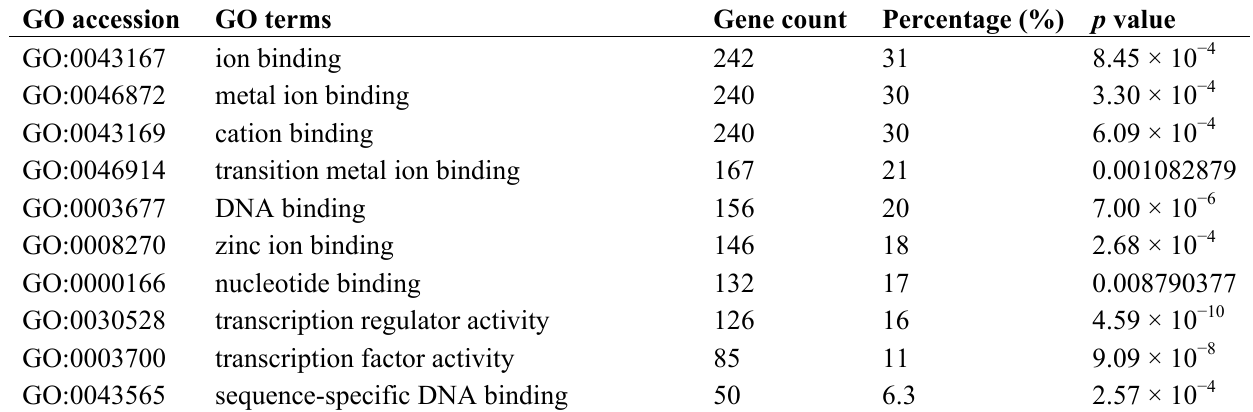
Table 8. The 10 most enriched GO categories in molecular